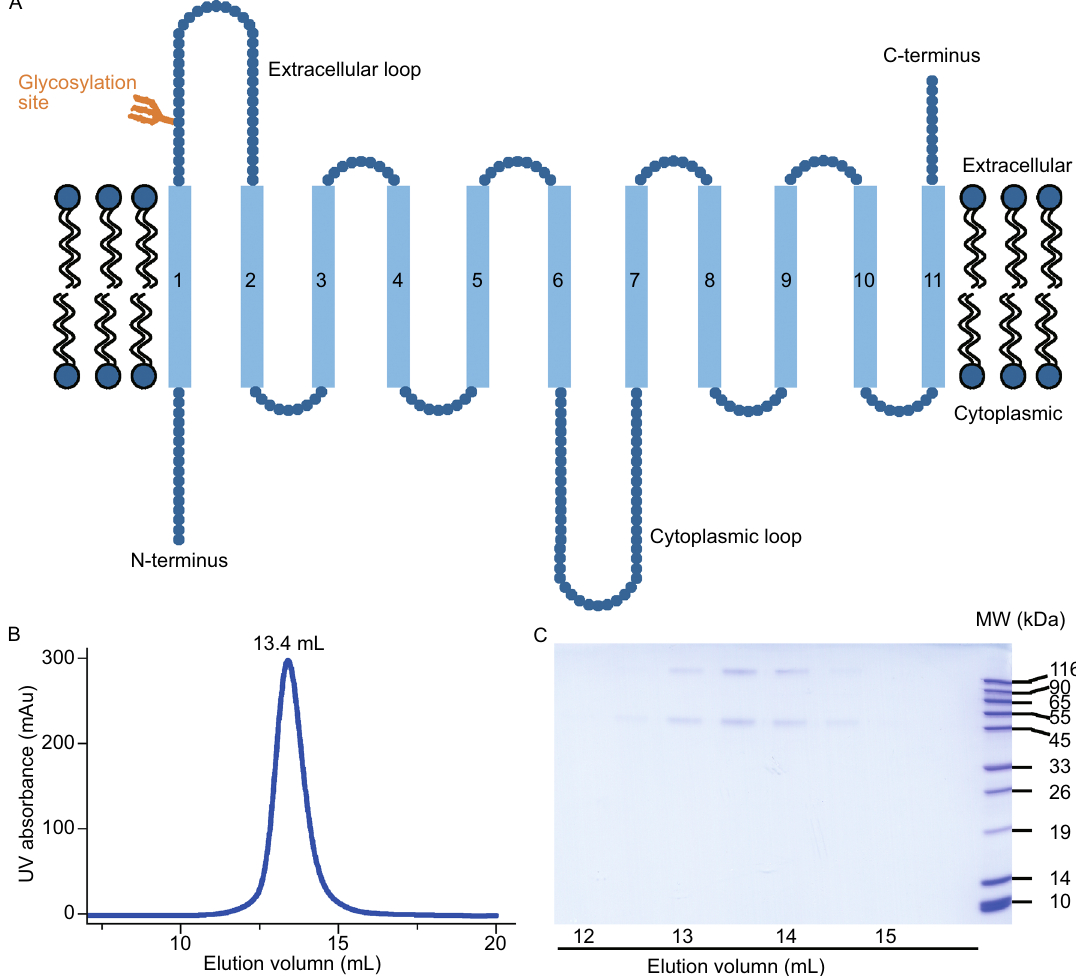
Figure 1. Expression and puri fi cation of hENT1 in HEK293F cells. (A) The predicted topology diagram of hENT1. hENT1 has 11 transmembrane segments, with a cytoplasmic amino-terminus and an extracellular carboxyl-terminus. The positions of the glycosylation site and two long loops are indicated. (B) A representative chromatogram of hENT1 from gel fi ltration chromatography. The elution volume of hENT1 in the Superdex-200 column gel fi ltration is indicated. (C) Visualization of hENT1 on a SDS-PAGE gel. The peak fractions from gel fi ltration were applied onto a SDS-PAGE gel followed by coomassie blue